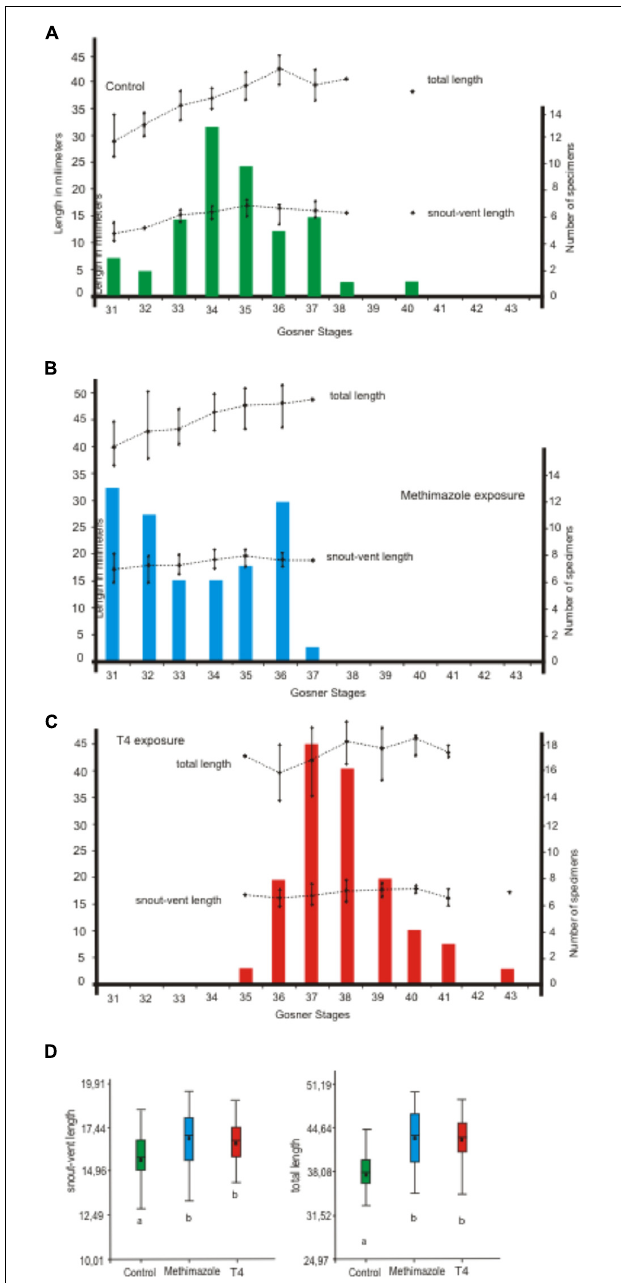
FIGURE 4 | Variation in size of each larval stage of Pleurodema borellii during late exposure to methimazole and T4. (A–D) The experiment began at 18 after hatching. Tadpoles were exposed for 13 days (seven doses). (A) Control specimens. (B) Tadpoles exposed to methimazole. (C) Tadpoles exposed to T4. (D) Significant differences were found in size variables ( p < 0.05 for snout-vent length and total length) between each treatment and the control. However, no significant differences were found among size variables between tadpoles exposed to methimazole and tadpoles exposed to